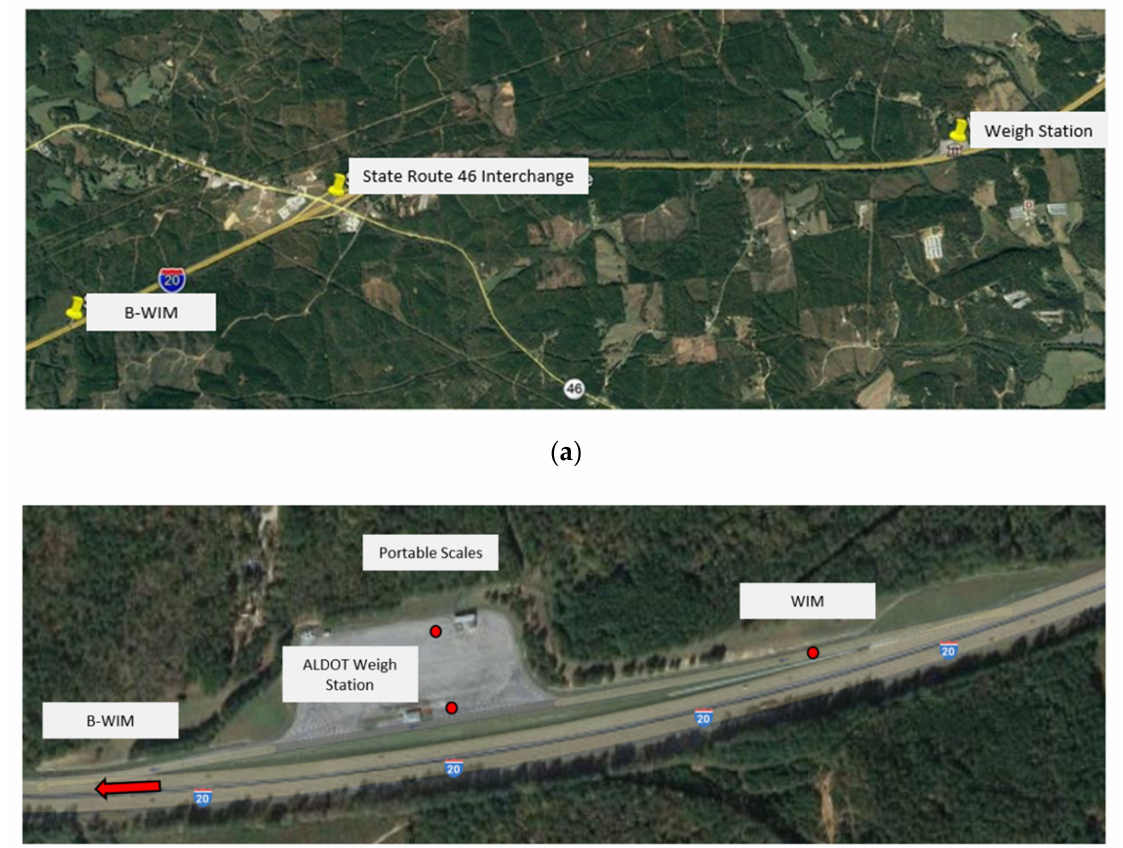
Figure 1. Considered truck weigh systems: ( a ) overview, ( b ) specific locations